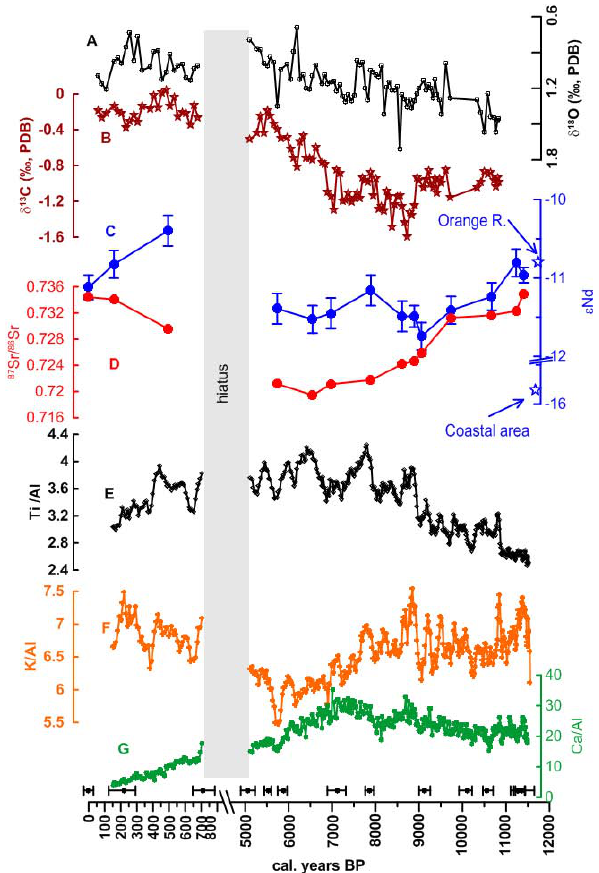
Fig. 4. Proxy time series analyzed in sediment core GeoB8332-4. (A) and (B) δ 18 O and δ 13 C analyzed in tests of N. pachyderma (sinistral). (C) and (D) ε Nd and 87 Sr/ 86 Sr analyzed in the detrital fraction. Average ε Nd value of the Orange River and riverbed sedi- ments from the coastal area indicated by stars on the y axis. Vertical bars indicate analytical error estimates for ε Nd. Analytical error es- timate for 87 Sr/ 86 Sr is smaller than the dots indicating individual measurements. Ti/Al (E) , K/Al (F) , and Ca/Al (G) analyzed in bulk sediment of GeoB8332-4 using XRF-Scanning. Black filled circles and horizontal bars indicate age model control points and error estimate (2 σ) related to 14 C measurements and conversion to calendar age, respectively.